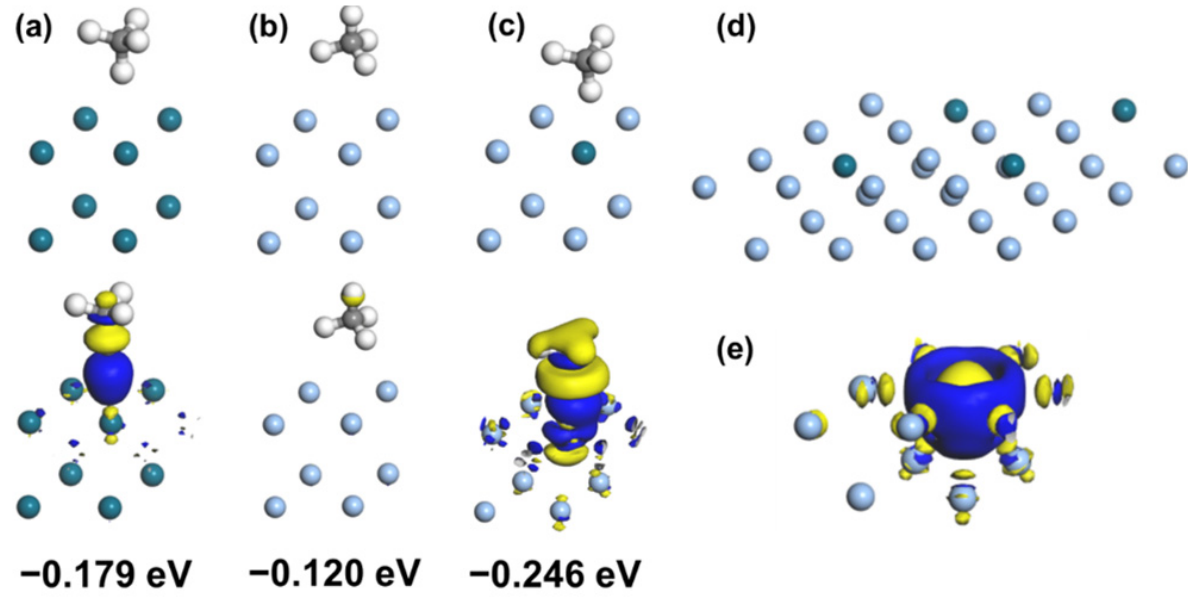
Figure 8. Adsorption energy, spatial configuration and charge density difference of CH 4 molecule on ( a ) Pd(111), ( b ) Ag(111) and ( c ) Ag(111)@Pd surface. ( d ) Relaxed configurations of Ag(111)@Pd surface. ( e ) Charge density difference of the Pd atom on the Ag(111)@Pd surface. Blue indicates electron gain, and yellow indicates electron